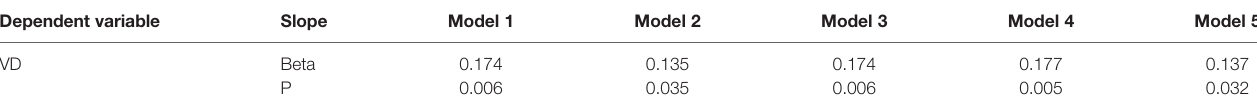
TABLE 4 | Multiple linear regression analysis of 25(OH)D, testosterone and other parameters. Dependent variable